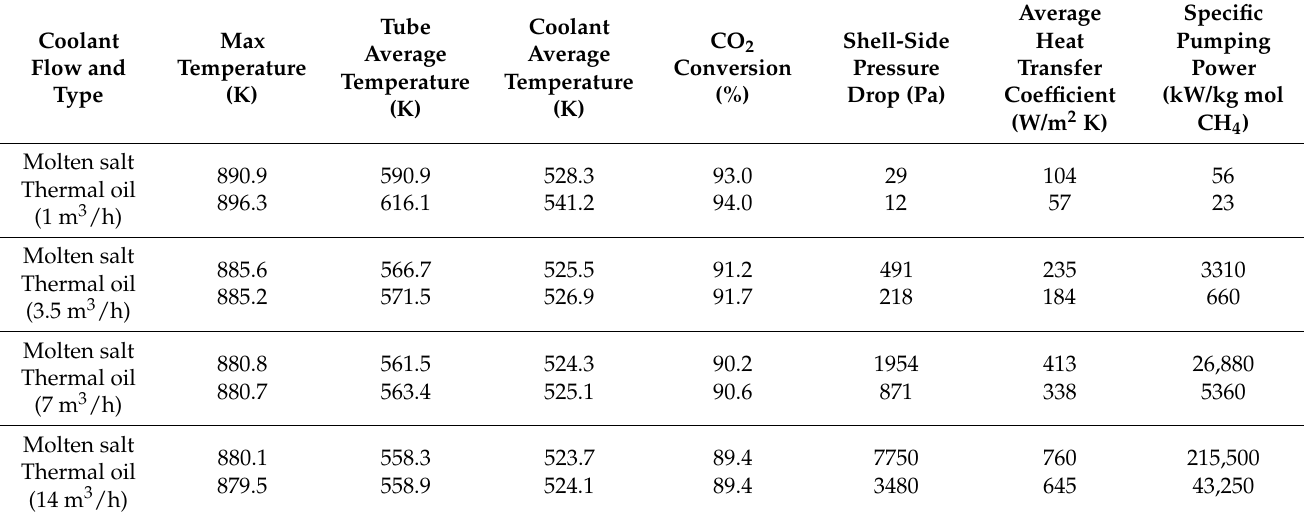
Table 5. Reactor Performance comparison between coolants (molten salt vs. thermal